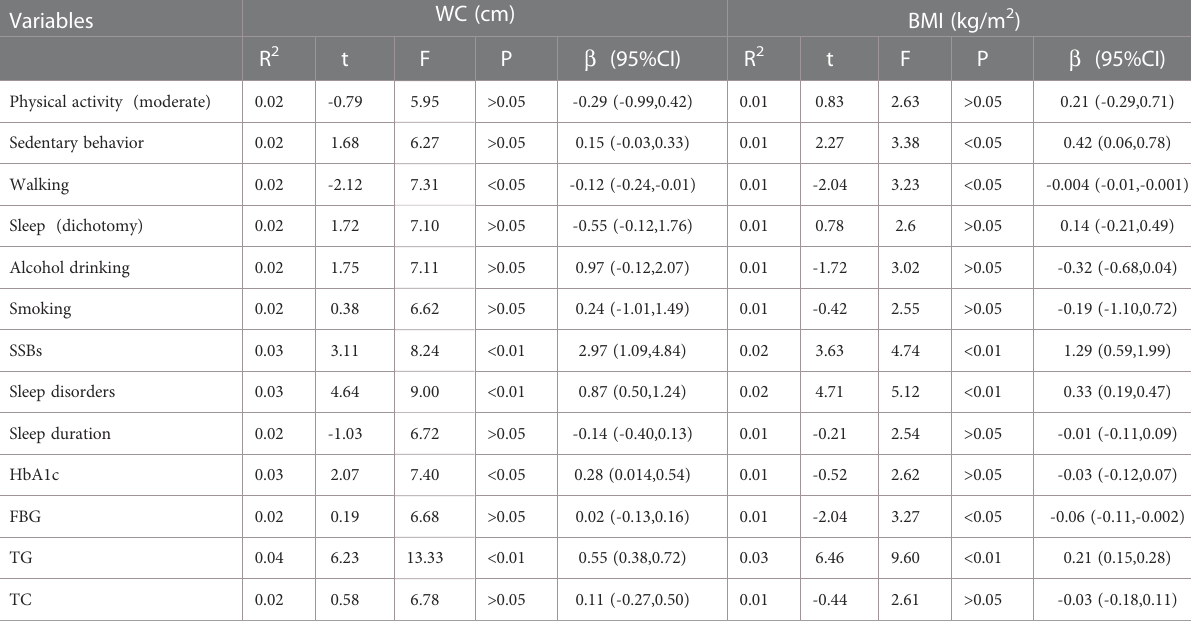
TABLE 2 The multilevel linear regression between dependent health risk factors and WC. Variables WC